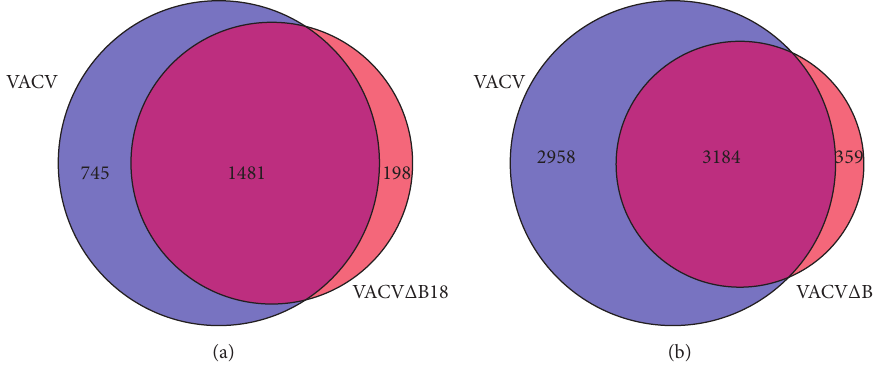
Figure4:EffectofB18absenceonhostgeneexpressionduringVACVinfection.Venndiagramsshowingthenumberofoverlappedtranscripts corresponding to cellular genes differentially expressed between VACV- and VACV Δ B18-infected cells at 4hpi (a) and 9hpi (b) are